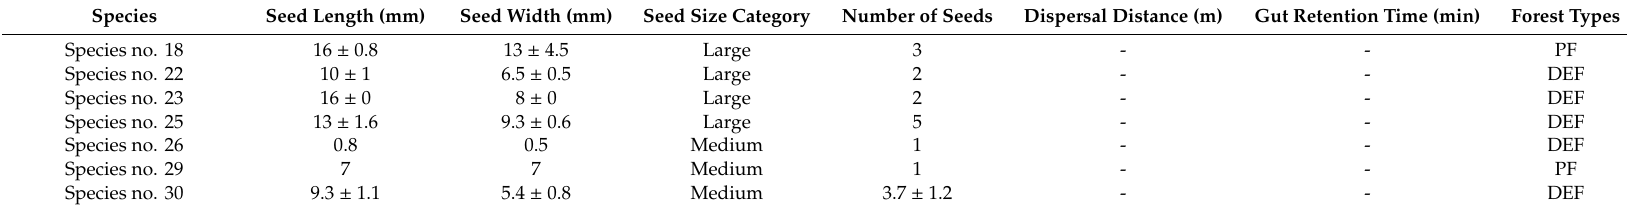
Table 4. Intact seed species spat out by macaques in Sakaerat: mean size ± SD, mean number ± SD, observed mean dispersal distance ± SD, mean cheek pouch retention time ± SD. Species Afzelia xylocarpa Aglaia sp. Beilschmiedia